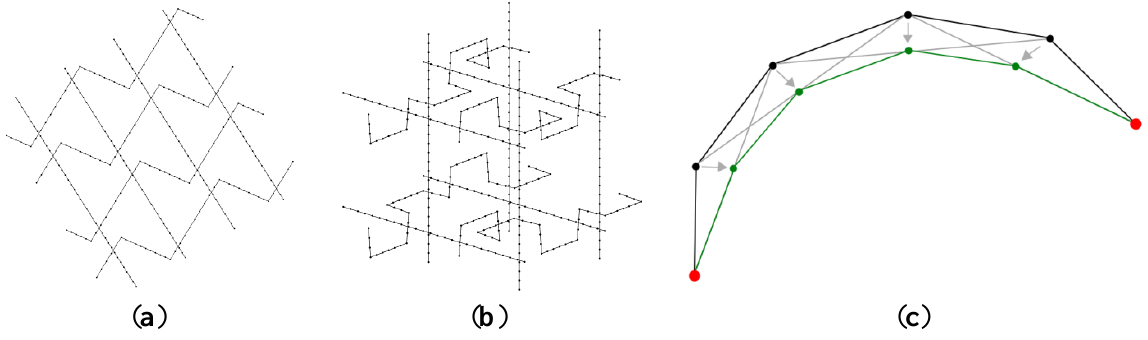
Figure 1. ( a ) Input data used for the weave generation process of a simple weft-warp yarn system; ( b ) 3D weaving similar to that reported in [22]; and ( c ) Fundamental operation (A) for tensioning of the yarns. Black lines represent the position of the yarn centerline prior to the operation (A), while green lines represent its position after operation (A). Grey lines are segments linking the neighbors of each of the vertices. Red dots represent fixed vertices at the extremities of the